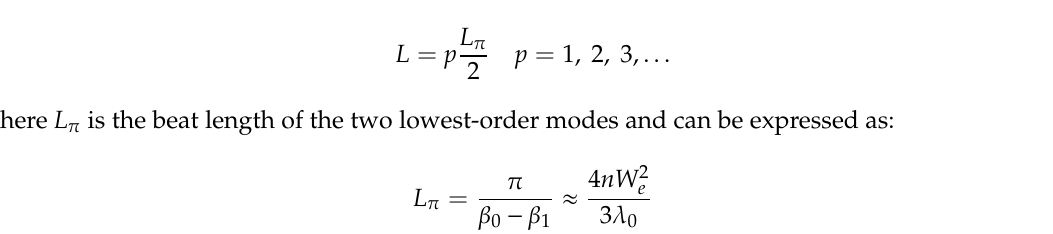
Figure 3. The structure of the MMI coupler.